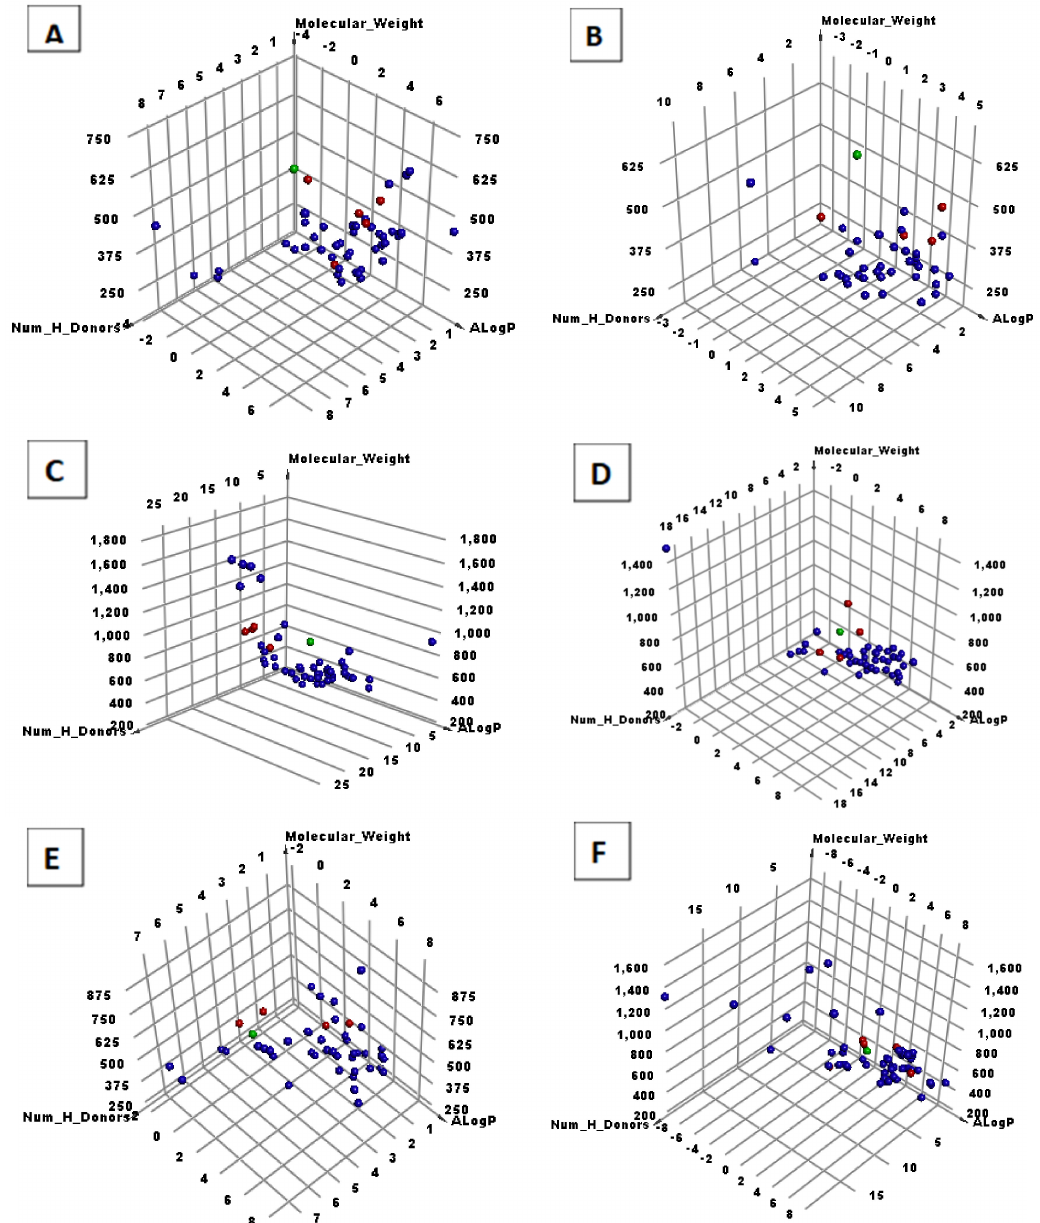
Figure 1. Structural similarity between GWS and the examined metabolites. Green = GWS , red = similar metabolites, blue = dissimilar metabolites. ( A ) Metabolites 1–50; ( B ) metabolites 51–100l; ( C ) metabolites 101–150; ( D ) metabolites 151–200; ( E ) metabolites 201–250; ( F ) metabolites